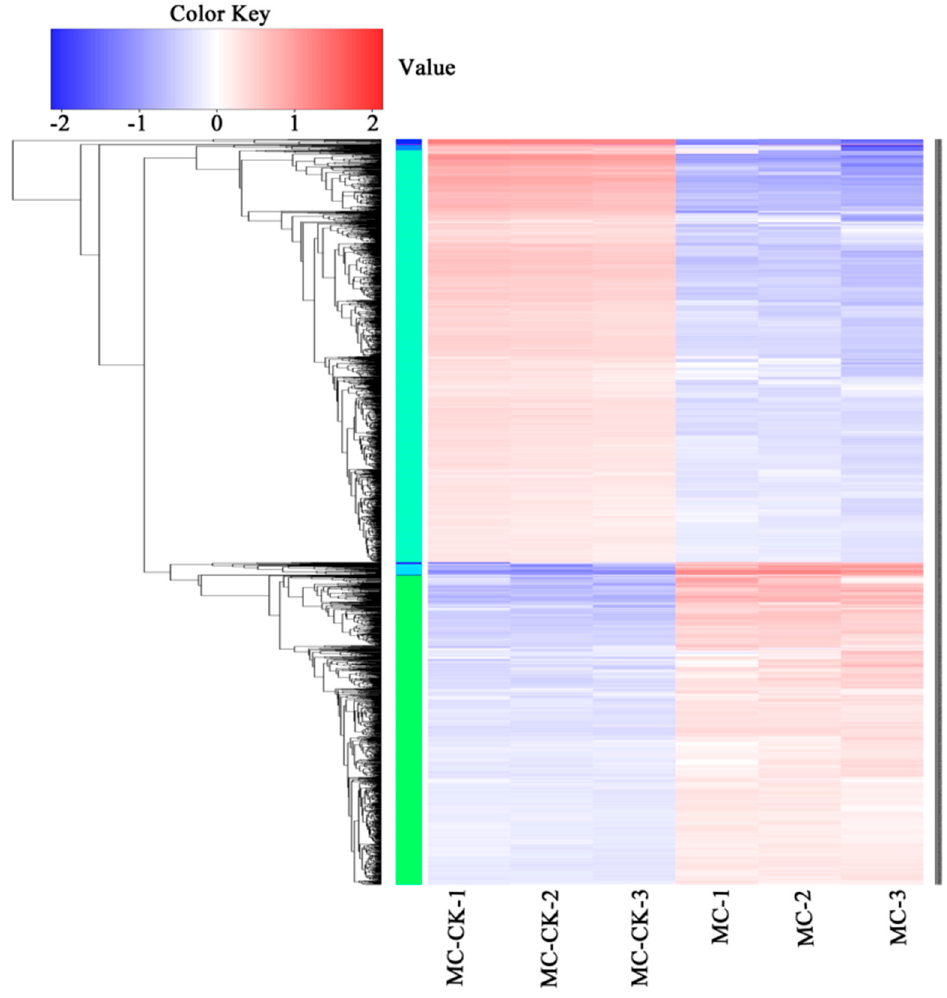
Figure 6. Clustering heatmap of differentially expressed genes.